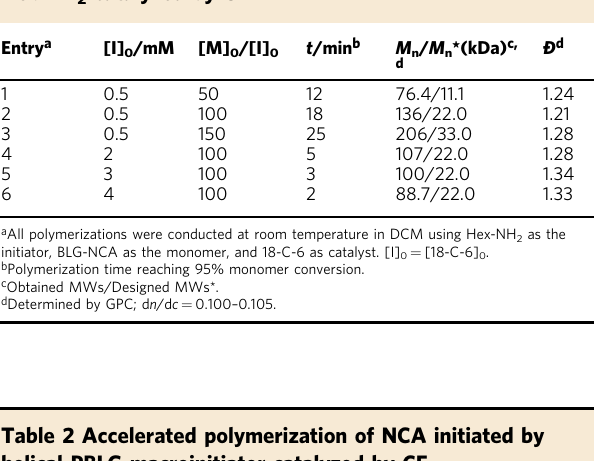
Table 1 Accelerated polymerization of NCA initiated from Hex-NH 2 catalyzed by CE.